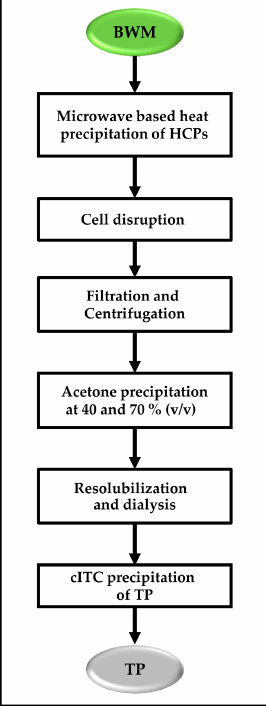
Figure 7. Low-tech pilot scale purification scheme for the capture and polishing of a spider silk analog. Up to 6 kg BWM were processed. In total, 413 mg Q-MaSp1-100× ELP and 273 mg K-MaSp1-100× ELP were isolated.